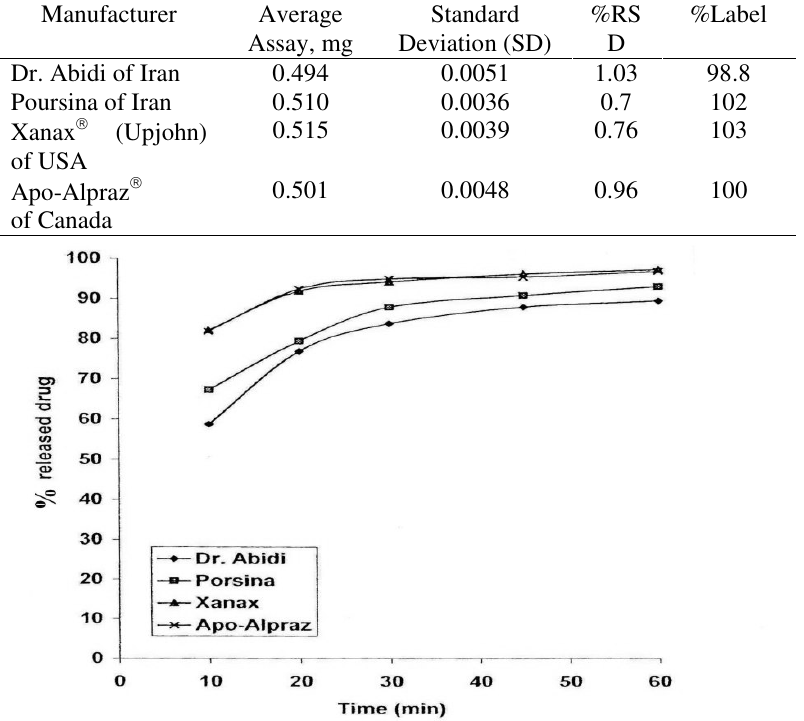
Figure 3 . Comparison of the curves of the average percentage released of the active ingredient of alprazolam tablets at various